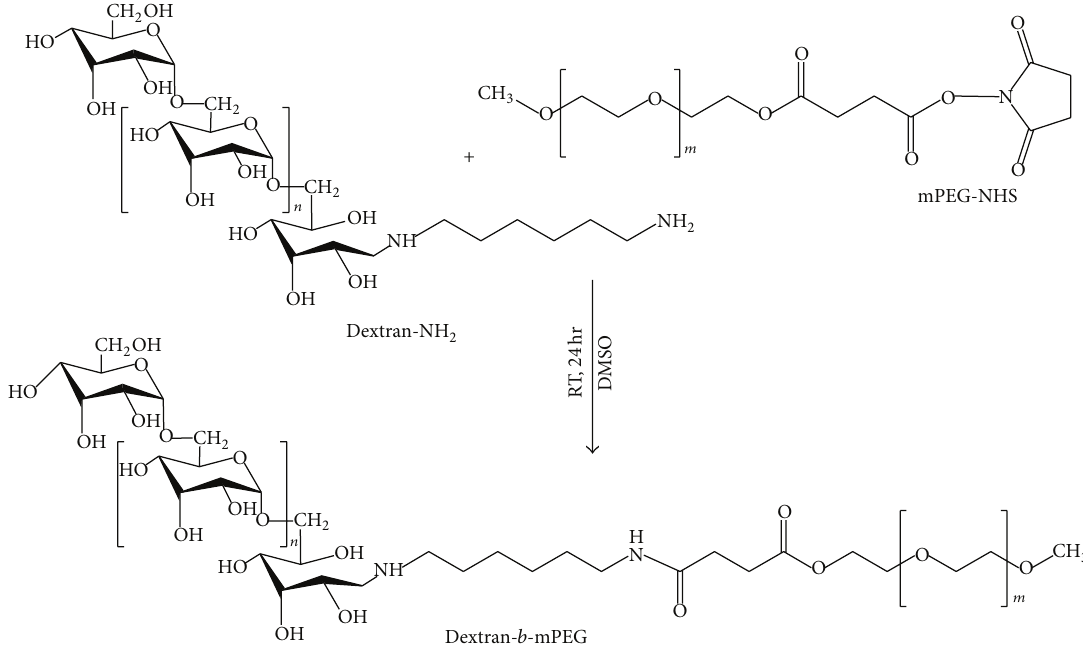
Figure 3: Synthesis scheme of DexPEG block